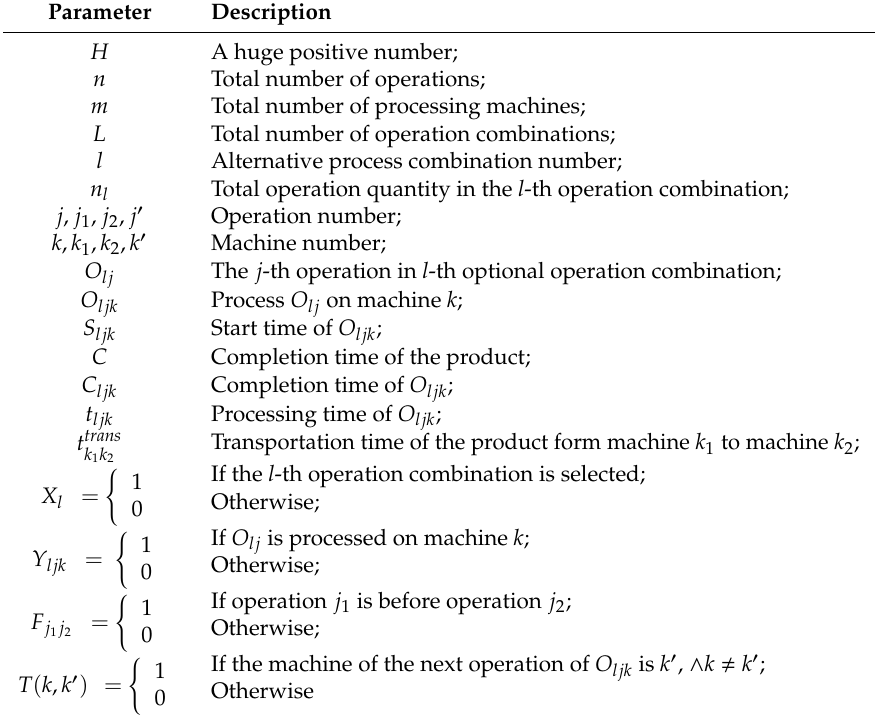
Table 2. The relevant parameter descriptions of the process